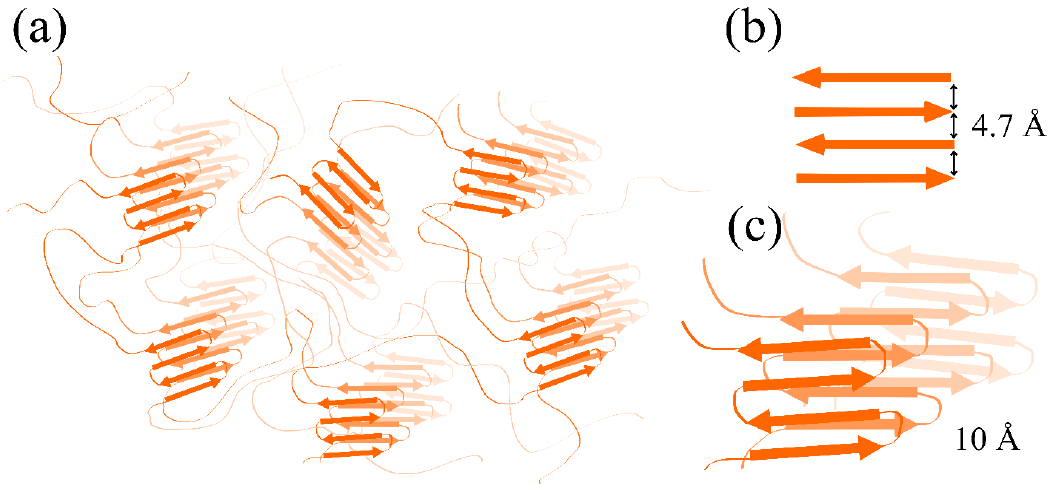
Figure 9. A schematic of the internal structure of aggregates with a cross- β -sheet structure, formed by smooth-muscle titin. ( a ) The proposed structure of SMT aggregates based on circular dichroism, FTIR and X-ray diffraction data, suggesting the presence of a large amount of disorder. ( b ) A beta sheet and the distance of 4.7 Å between the beta strands. ( c ) The beta sheets and the distance of 10 Å between them are shown separately.